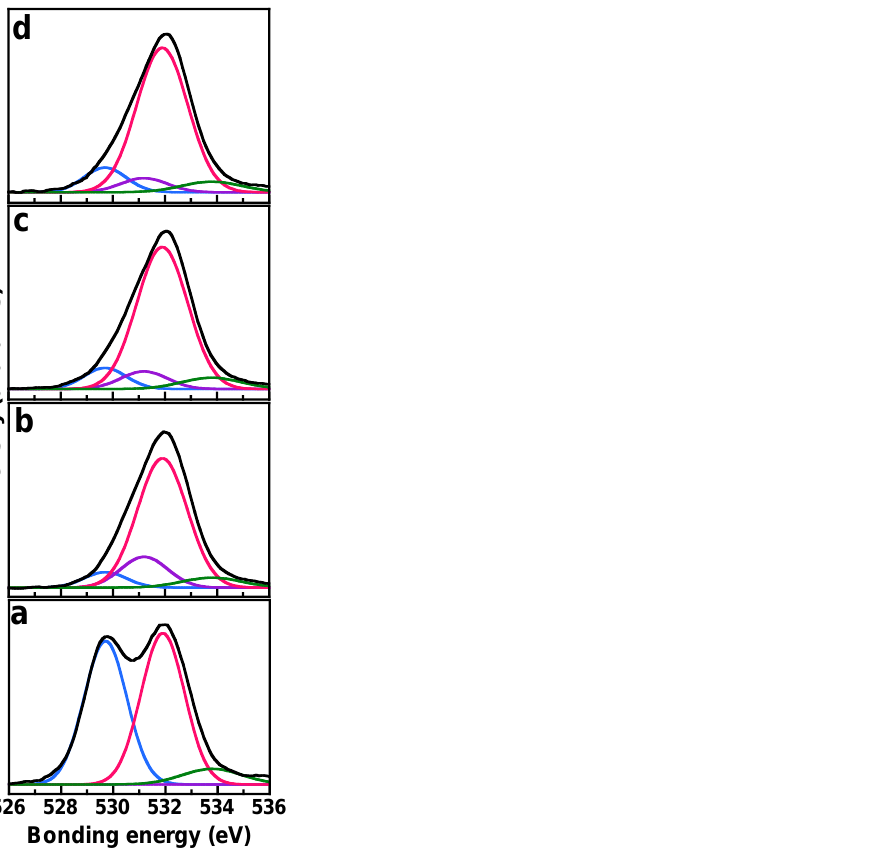
Figure 8. O 1s XPS spectra of surfaces of SiO 2 /ZrO 2 ‑coated substrates. The black curves are the measured spectra. The numbers of etches are 0, 1, 2, and 3 for spectra ( a – d ), respectively. Each measured spectrum is fitted with Gaussian peaks, giving binding energies of 529.7 eV (blue curve), 531.2 eV (purple curve), 531.9 eV (red curve), and 533.8 eV (green curve), attributed to the O atoms of Zr–O, Si–O–Zr, Si–O, and Si–OH, respectively. The as‑prepared sample was the same as that in Figure 5(b1).